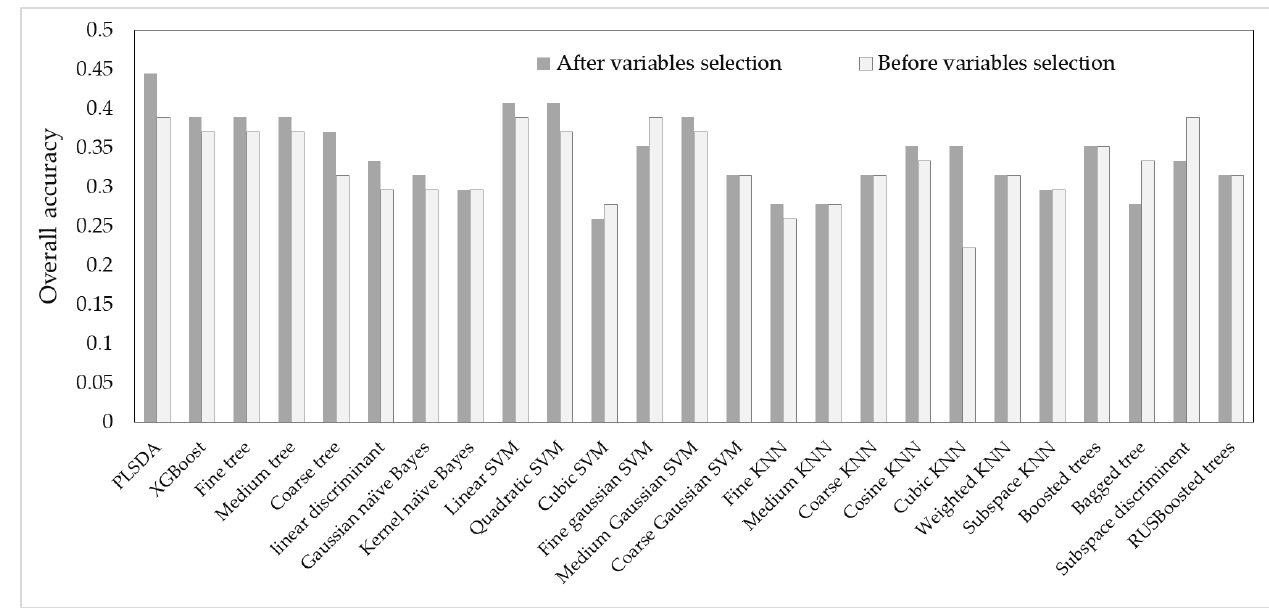
Figure 5. The overall accuracies of different classification learners before and after variable selec- tion.